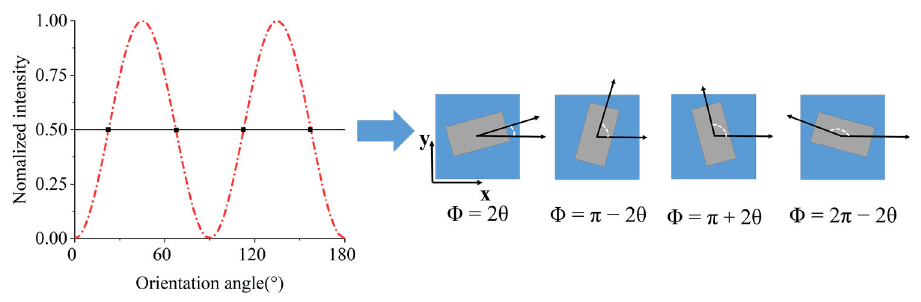
Figure 2. The principle of orientation angle degeneracy. The same output light intensity has four candidate orientation angles. The four candidate orientation angles can generate four different geo ‐ metric phases.